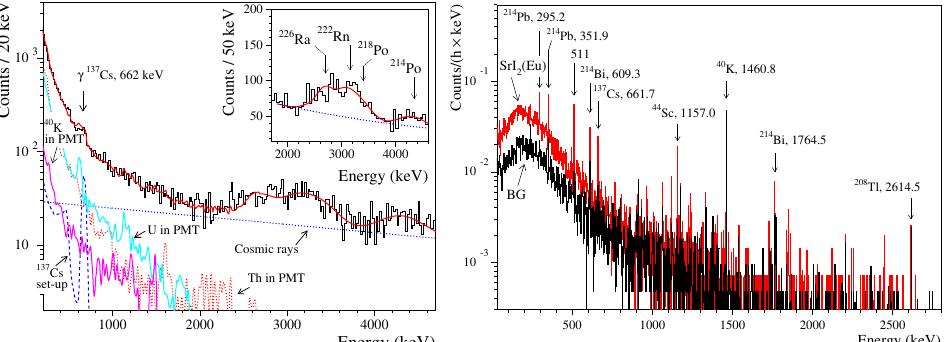
Figure 10. (Color online) Left : Energy spectrum measured with a SrI 2 (Eu) crystal scintillator in Ref. [13] over 101.52 h. The model of the background is also reported together with the main components of the external background and of the cosmic rays. (Inset) The structure in the region (2.5–4.3) MeV is due to α activity of trace U/Th contamination of the crystal scintillator. Right : Energy spectra measured by a ULB HPGe γ spectrometer deep underground in Ref. [13]. The measurements were performed with the SrI 2 (Eu) sample (706 h) and without it (BG, 1046 h). The reported γ lines energies are in keV. The BG spectrum was measured before the contamination of the set-up by a 44 Ti (1157 keV peak of 44 Sc). Reprinted with permission from [73]. Copyright 2020 IOP